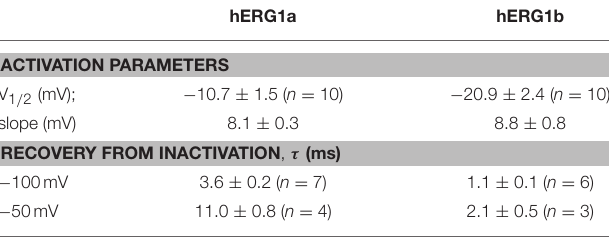
TABLE 1 | Experimental data for HEK cells at room